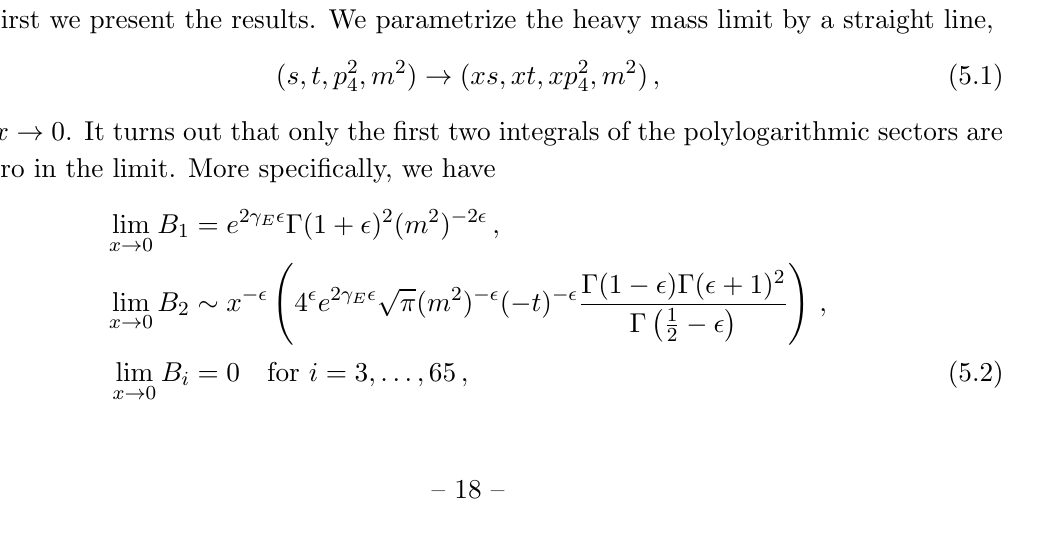
Figure 4 . Plot of the integrals B (4) The solid points represent values computed numerically with the software FIESTA